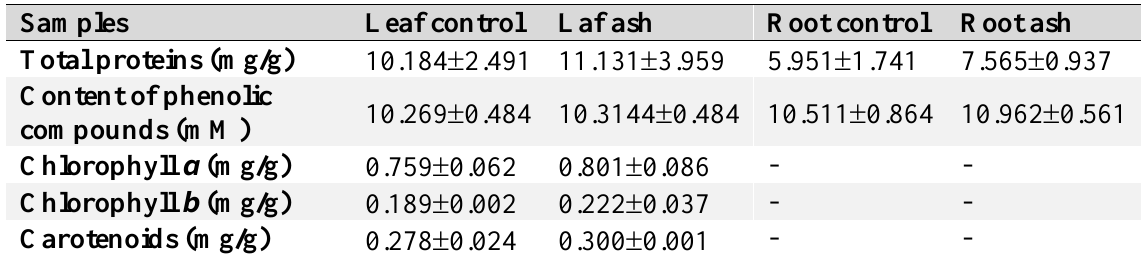
Table 2. Content of total proteins, chlorophyll a , chlorophyll b and phenolic compounds in roots and leaves of R. obtusifolius plants grown on uncontaminated area and ash amended